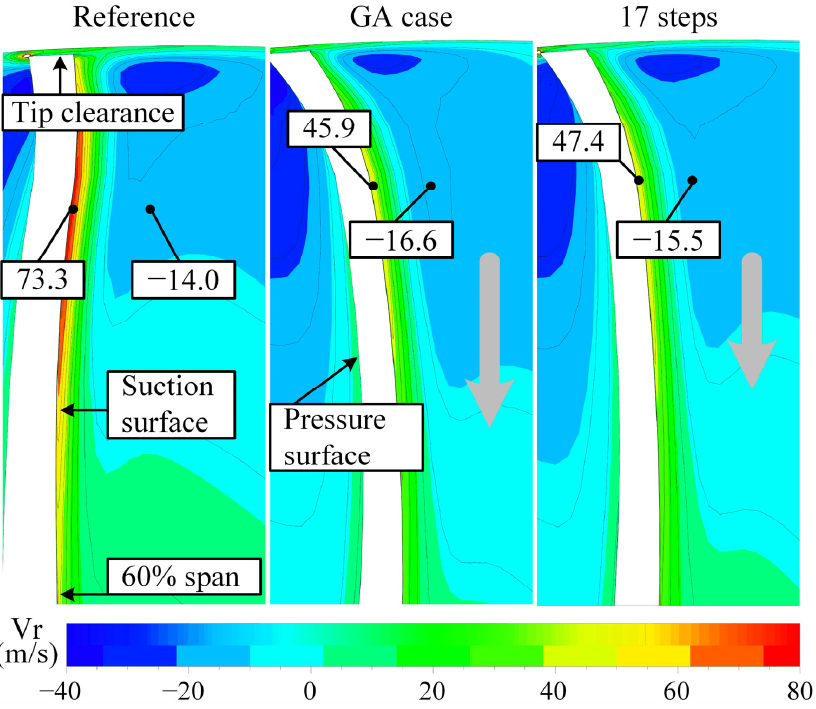
Figure 20. Radial velocity at the axial surface (80% length).